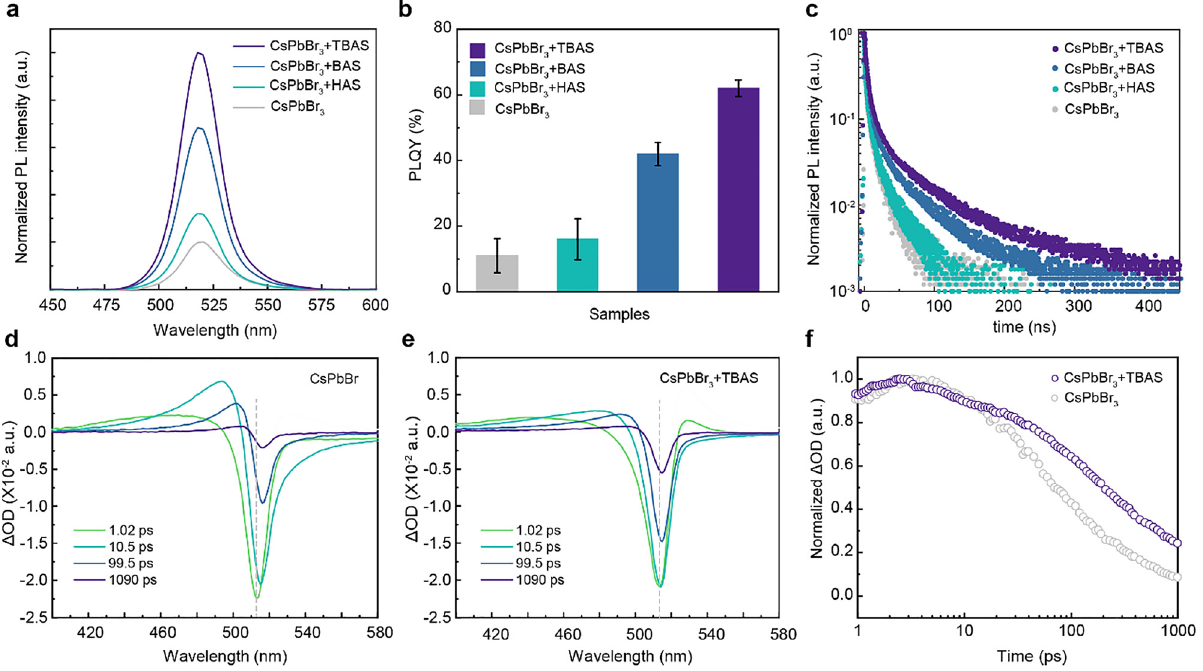
Figure 4: Optical characterizations of the CsPbBr 3 perovskite fi lms. (a) Steady-state PL spectra, (b) photoluminescence quantum yield (PLQY) values, and (c) time-resolved PL (TRPL) spectra of original CsPbBr 3 fi lm and CsPbBr fi lms incorporated with hexanoic acid sodium salt (HAS), benzoic acid sodium salt (BAS), and 4-(tri fl uoromethyl) 3 benzoate acid anion (TBA), respectively. Transient absorption maps of the (d) original and (e) 4-(tri fl uoromethyl) benzoate acid sodium salt (TBAS)-containing CsPbBr 3 fi lms. (f) Transient absorption (TA) decay kinetics of the original and TBAS-containing CsPbBr 3 fi